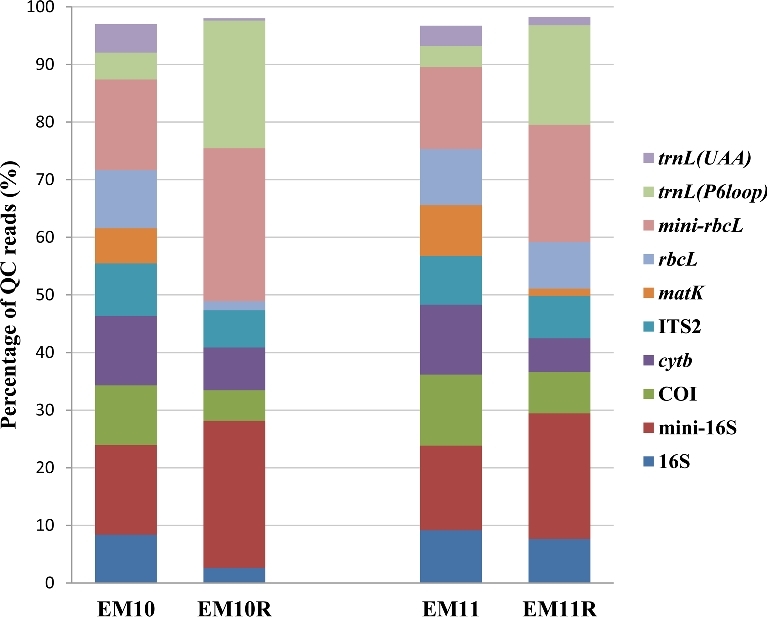
The percentage of QC reads assigned to DNA barcodes for samples EM10, EM10R, EM11, and EM11R of the pilot study.